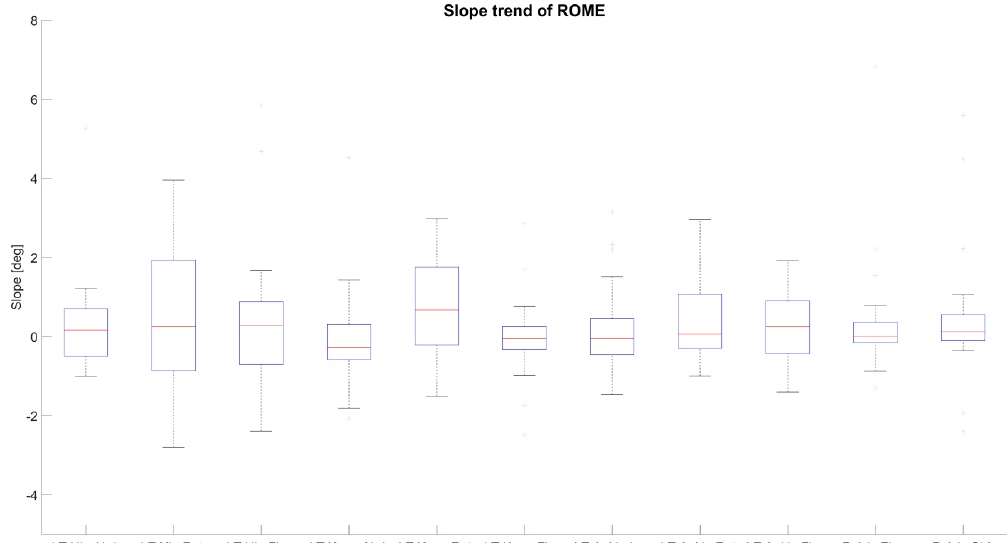
Figure 7. Evaluation of linear regression of ROME for condition 2 over time exemplary for the left lower extremity and global pelvis angles in sagittal and frontal plane. On the vertical axis is the slope of the regression line in degree. Median slope values, quartiles as well as whiskers are above and below zero indicating no increasing trend of ROME over time.